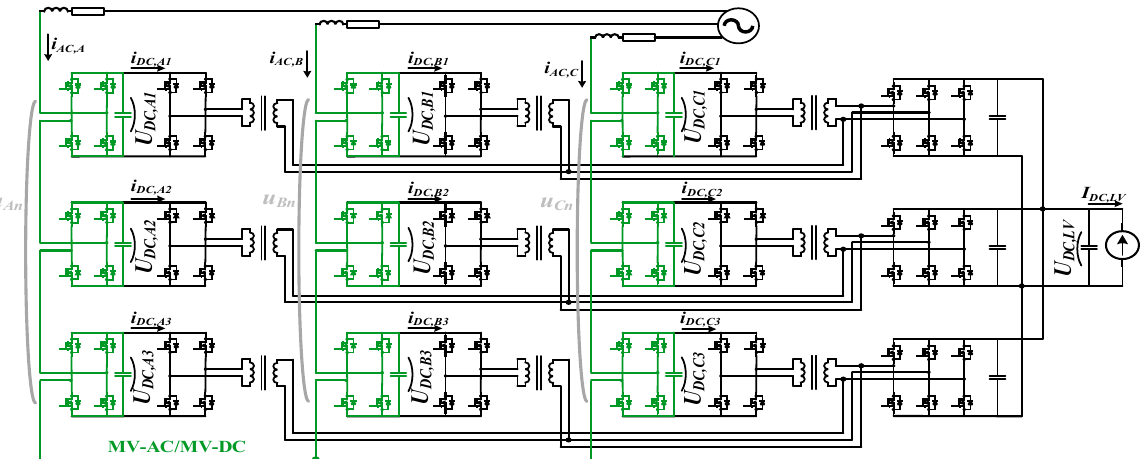
Figure 4. Considered MV-AC to MV-DC stage of SST based on a star-connected CHB converter.